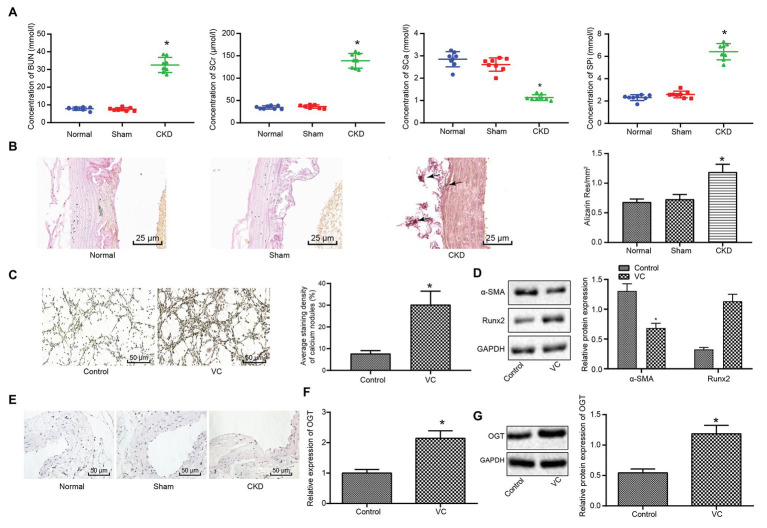
O-linked N-acetylglucosamine (GlcNAc) transferase (OGT) is highly expressed in vascular calcification (VC) rat models with chronic kidney disease (CKD) and in cell models of vascular smooth muscle cell (VSMC) calcification. (A) Quantitative analysis for levels of blood urea nitrogen (BUN), creatinine (SCr), calcium (SCa), and phosphate (SPi) in rat models as detected by kits. (B) Alizarin red S (ARS) staining and quantitative analysis showing calcified nodules in thoracic aorta of rat models. Black arrows indicate calcified nodules. (C) Von Kossa staining and quantitative analysis showing calcium deposition in cell models. (D) Western blot analysis of protein levels of calcification indicators Runx2 and α-smooth muscle actin (α-SMA) normalized to glyceraldehyde-3-phosphate dehydrogenase (GAPDH) in cell models. (E) Immunohistochemical analysis of OGT expression patterns in thoracic aorta of rat models. (F) Quantitative analysis for OGT mRNA expression patterns in cell models as detected by reverse transcription quantitative polymerase chain reaction (RT-qPCR). (G) Western blot analysis of protein levels of OGT normalized to GAPDH in the cell models. *p < 0.05 vs. sham-operated rats or control cells (n = 8 rats in normal group, sham group, and model group, and in vitro experiments were repeated three times independently in the control and VC groups).